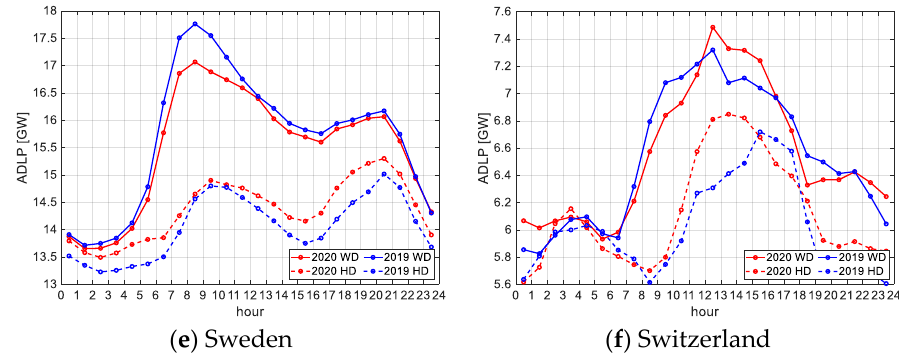
Figure 5. ADLP for the selected countries.